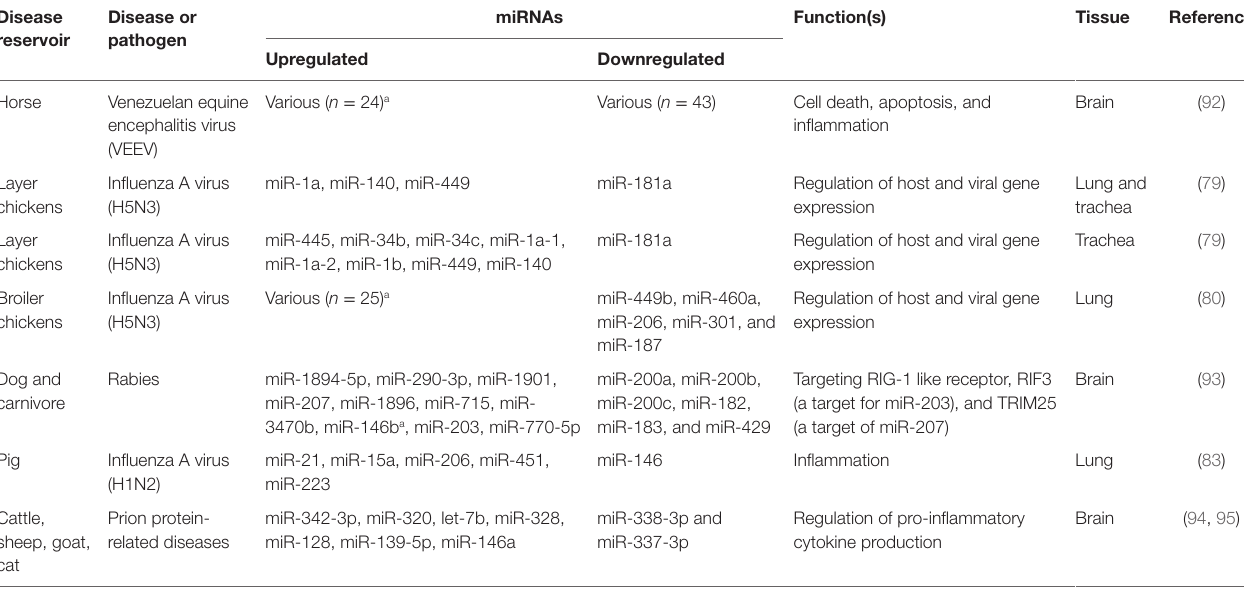
TABLe 1 | Selected studies reporting differentially expressed host-encoded miRNAs in animal viral infectious diseases of veterinary importance ( in vivo studies of natural infection and laboratory models). Disease Disease or reservoir